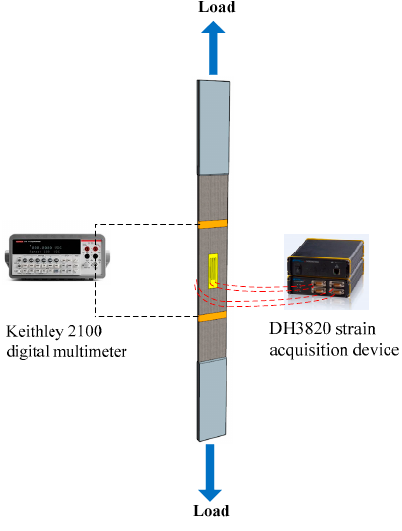
Figure 4. Setup of the in situ monitoring test.